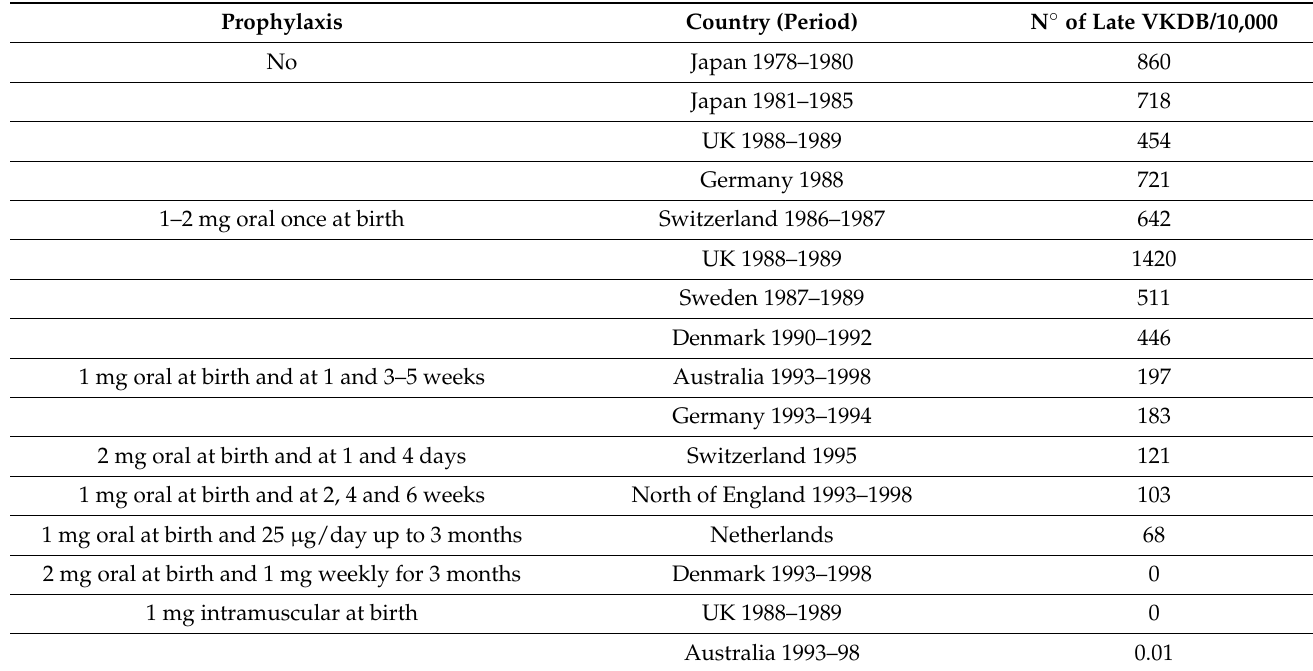
Table 7. Number (/10,000 cases) of late vitamin K deficiency bleeding in different populations according to prophylactic regimen (Adapted from ref.